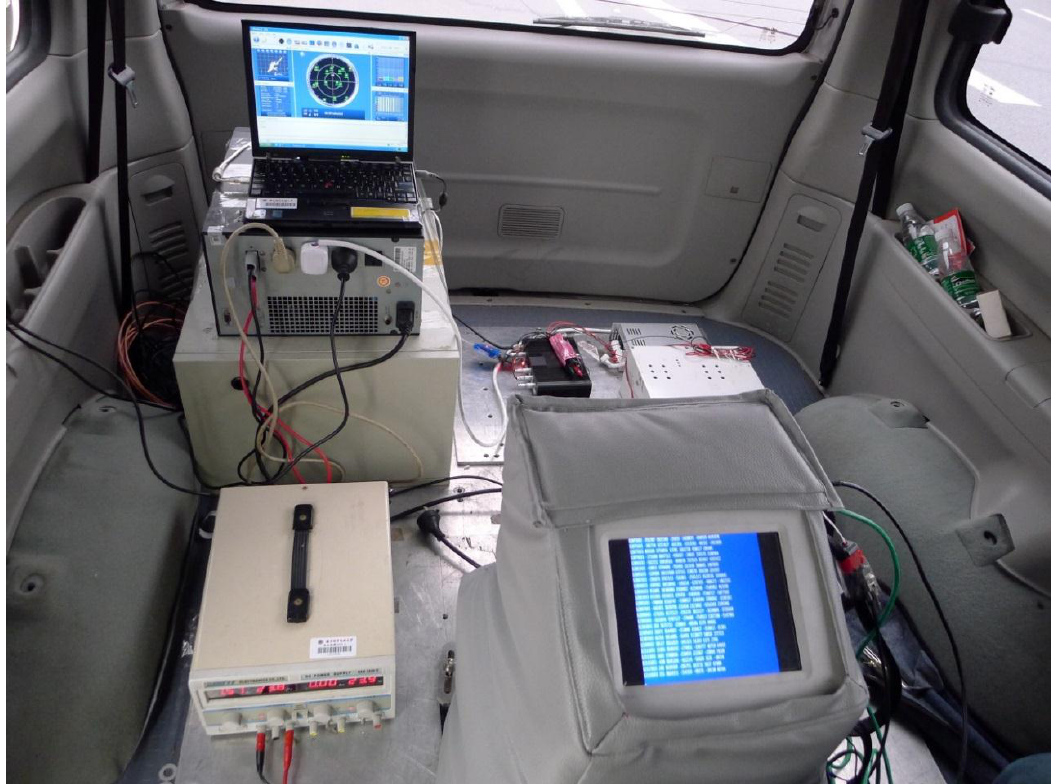
Figure 2. Working state of SGA-WZ02 on the test